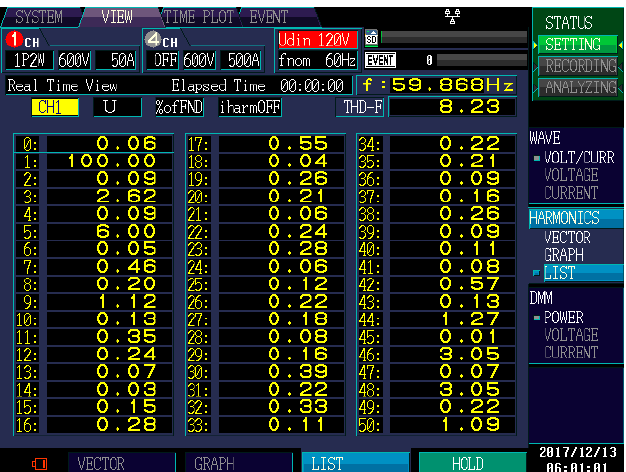
Figure 18. List of THD value of the seven-level asymmetrical CMLI in a reconfigured fault condi- tion.